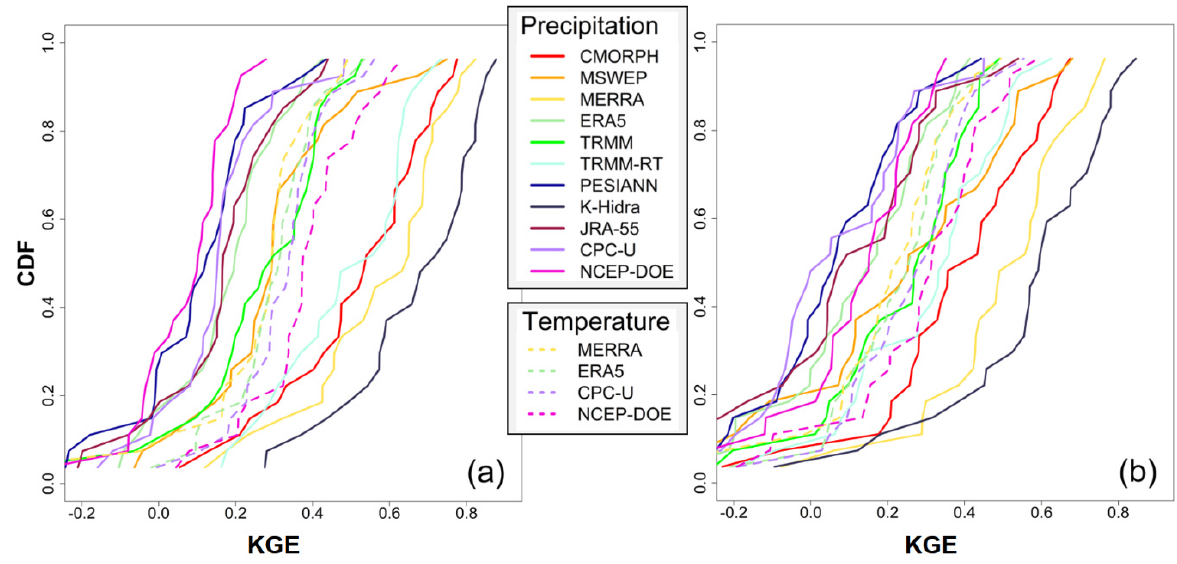
Figure 7. Cumulative density functions of Kling-Gupta efficiency of all streamflow gauges for the precipitation-focused aggregation (solid line) and temperature-focused aggregation (dotted line) over ( a ) the calibration and ( b ) the validation periods.